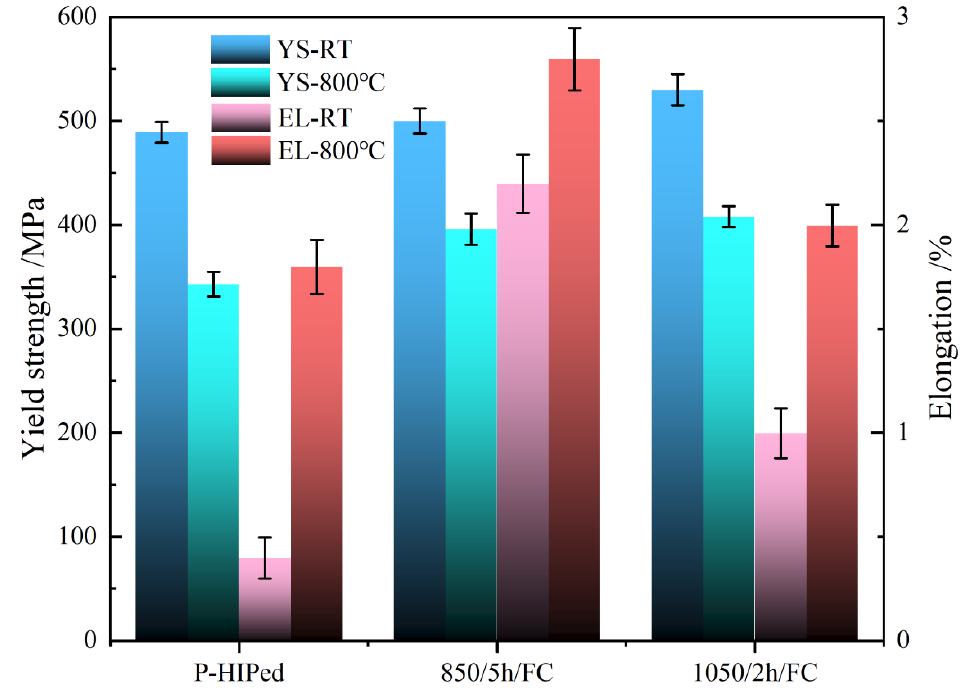
◦ C of P-HIPed TNM alloys with different Figure 6. Tensile properties at RT and 800 °C of P-HIPed TNM alloys with different conditions. Figure 6. Tensile properties at RT and 800